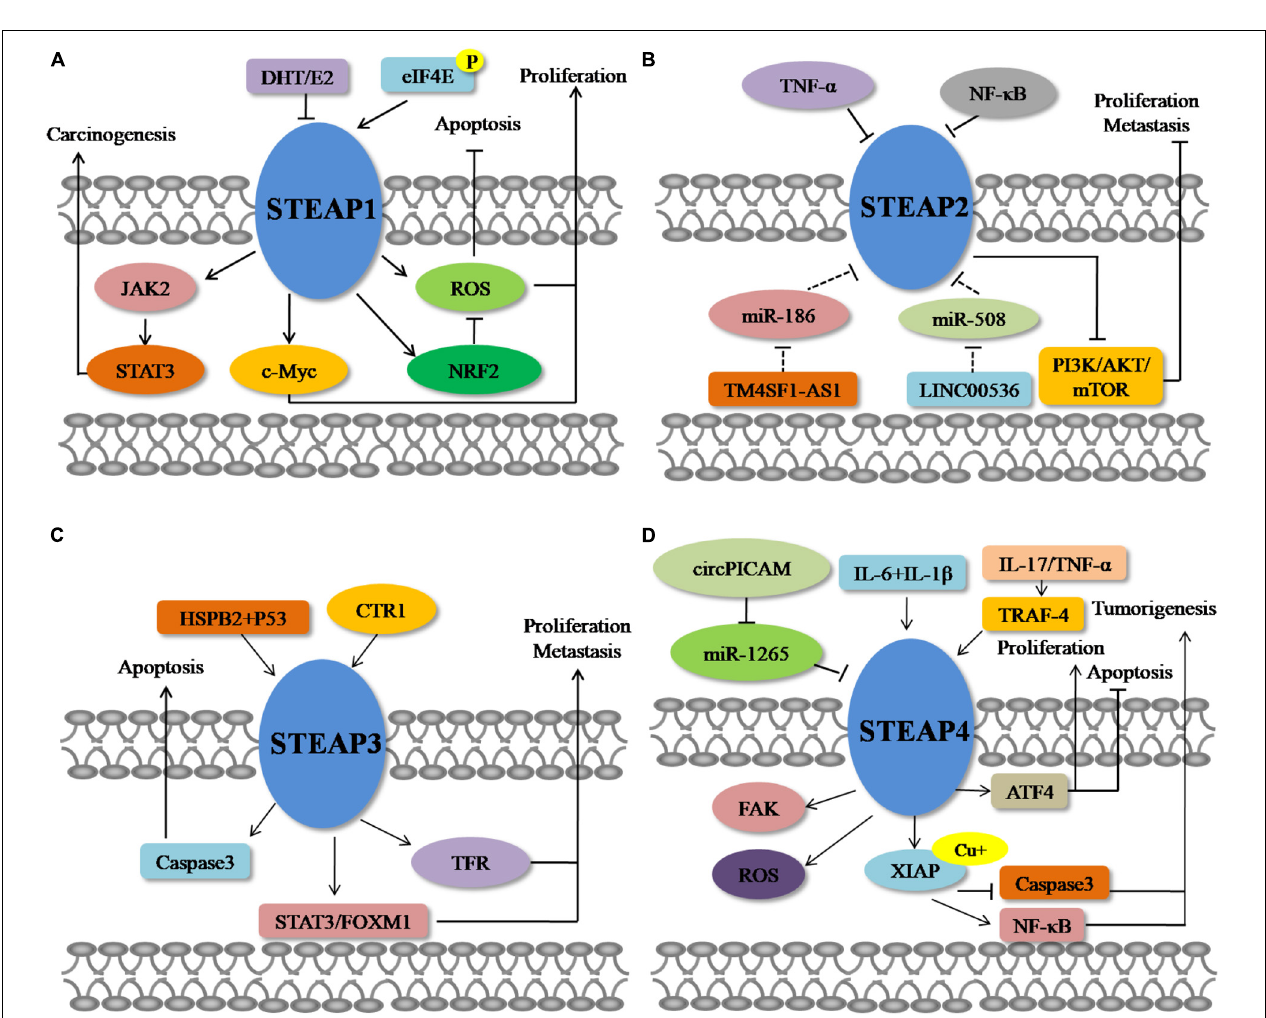
FIGURE 2 | Molecular mechanisms of STEAPs in cancer. (A) STEAP1. (B) STEAP2. (C) STEAP3. (D) STEAP4.